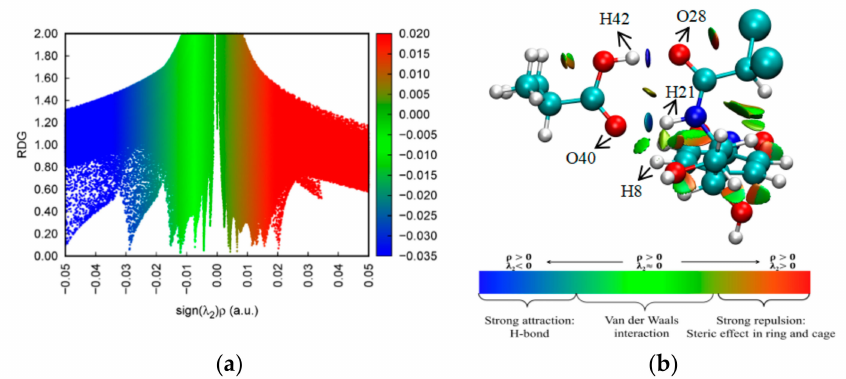
Figure 6. ( a ) Non-covalent interaction (NCI) scatter diagram and ( b ) reduced density gradient (RDG) analysis of the CAP–MAA